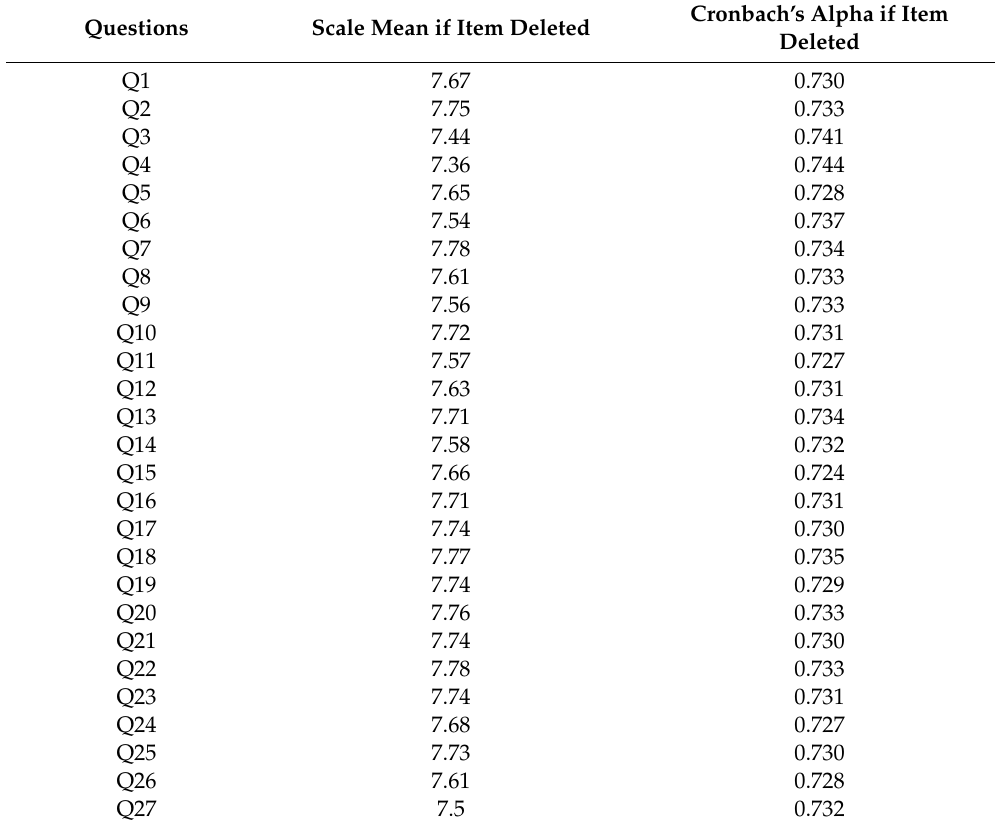
Table A3. Reliability analysis: Corrected item-total correlation of the sexually transmitted disease knowledge questionnaire and Cronbach’s alpha coe ffi